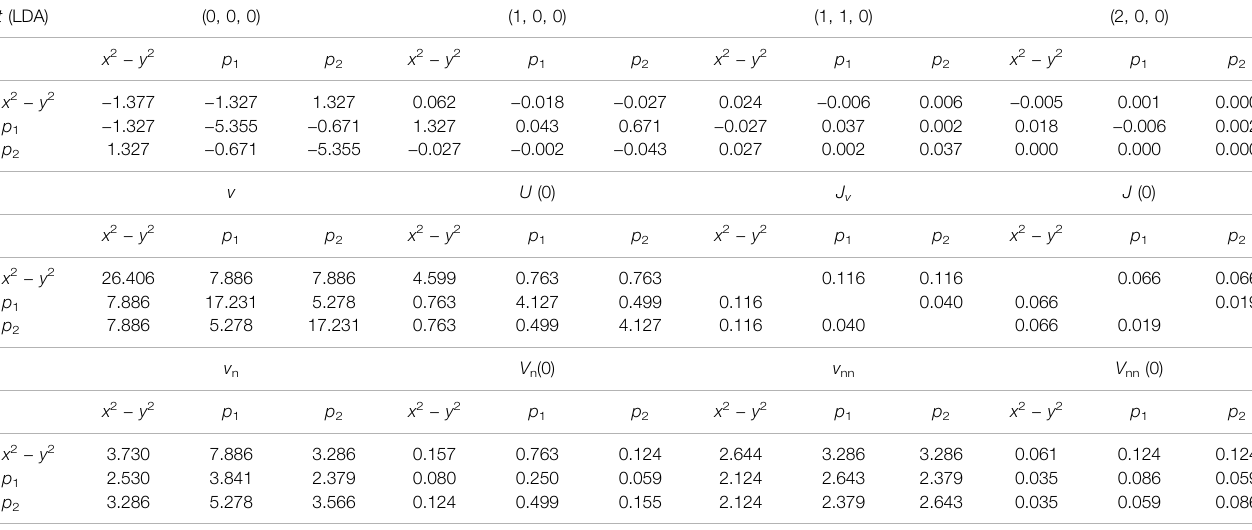
TABLE 1 | Transfer integrals and effective interactions in the three-orbital Hamiltonian for YNiO 2 (in eV). Both the one- and two-body part of the Hamiltonian are constructed basedontheLDAbandstructure. v , U (0), J v ,and J (0)representthebareCoulomb,thestaticvaluesoftheeffectiveCoulomb,bareexchangeinteractions,andexchange interactions, respectively (at ω =0). The index “ n ” and “ nn ” represent the nearest unit cell (1,0,0) and the next-nearest unit cell (1,1,0), respectively.